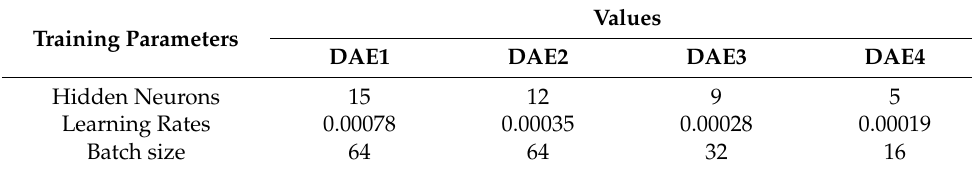
Table 2. Training hyperparameters optimized by BO.